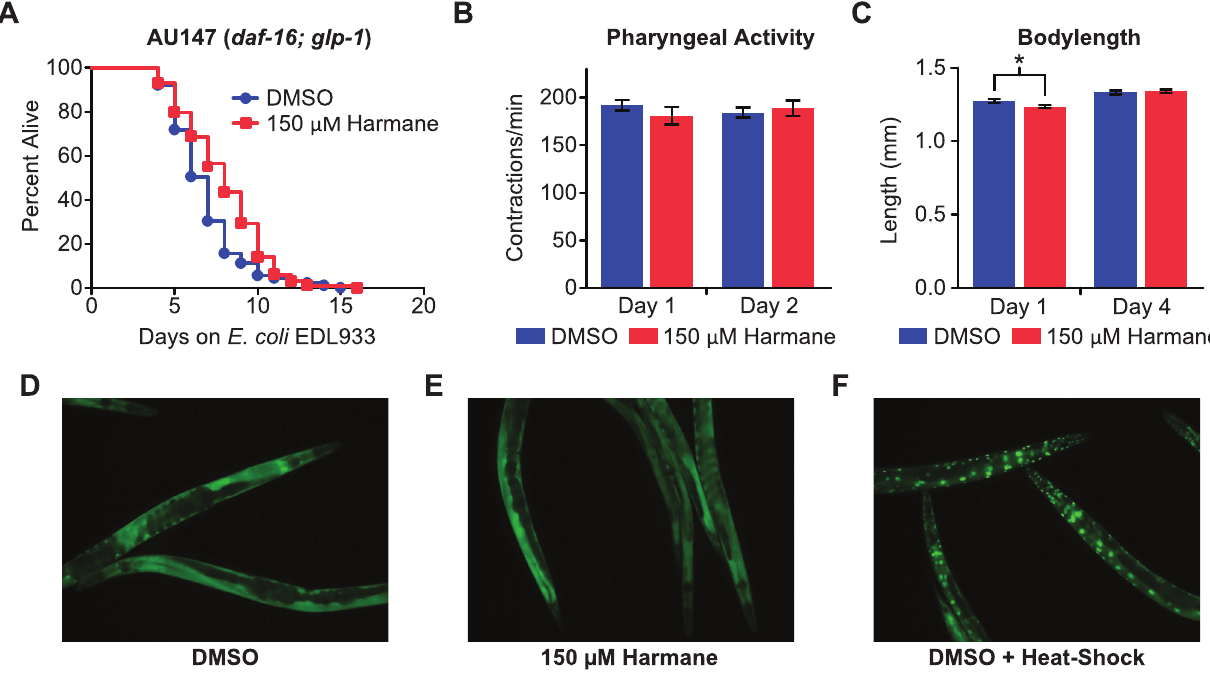
Figure 4. The effect of Harmane on the insulin-like receptor pathway. (A) E. coli EDL933 infection assay on daf-16 ; glp-1 nematodes exposed to Harmane and DMSO. The median survival on Harmane was 8 days, compared to 7 days on DMSO. This was lower than the lifespan extension seen in sek-1 ; glp-4 nematodes, however, still significantly different ( P , 0.0001) [DMSO, n=89; 150 m M Harmane, n=99]. (B) Pharyngeal pumping activity of sek-1 ; glp-4 nematodes (AU37) fed on E. coli OP50, exposed to DMSO or Harmane [DMSO, n=10; 150 m M Harmane, n=10; error bars indicate SEM]. (C) Body length of sek-1 ; glp-4 nematodes (AU37) fed on E. coli OP50, grown on DMSO or Harmane. Day 1 data shows a significant difference between Harmane and DMSO ( P =0.0242) [DMSO, day 1, n=68; 150 m M Harmane, day 1, n=72; DMSO, day 4, n=72; 150 m M Harmane, day 4, n=75; error bars indicate SEM]. (D) Fluorescence microscopy pictures of daf-16::gfp transgenic C. elegans after feeding 20 hours on E. coli OP50, grown on either DMSO or (E) 150 m SM Harmane. (F) Nematodes from a DMSO plate exposed to 37 u C for 30 minutes, just prior to being analyzed (positive control of DAF-16 translocation to nucleus). We could not detect any effect of Harmane on DAF-16 in the worms, as a result of the Harmane treatment. Pictures taken after 1 hour exposure to DMSO or Harmane (not shown), were identical to the 20-hour